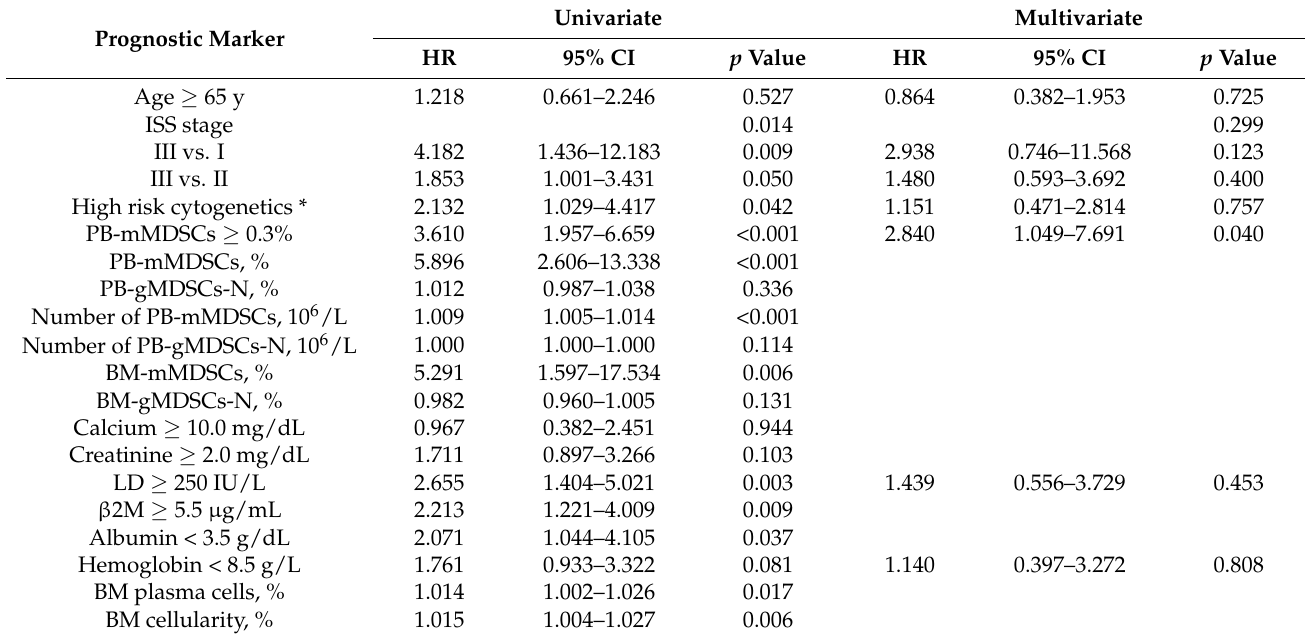
Table 4. Cox regression analysis in 81 patients newly diagnosed with plasma cell